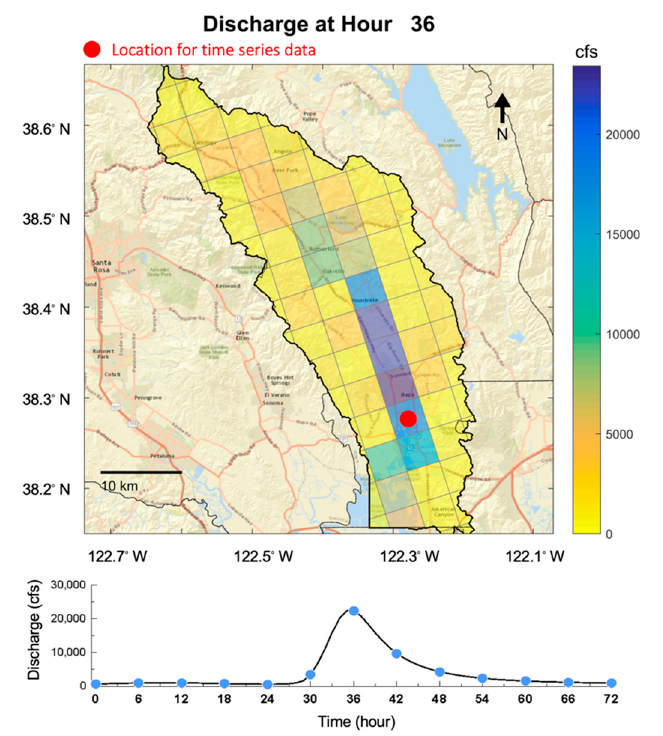
Figure 5. Output from the watershed component of Hydro-CoSMoS showing ( top ) discharge across the Napa River watershed at hour 36 during the storm scenario and ( bottom ) the basin outlet streamflow hydrograph generated from the watershed scenario that was used as input into CoSMoS. The location of the hydrograph is indicated by the red dot.